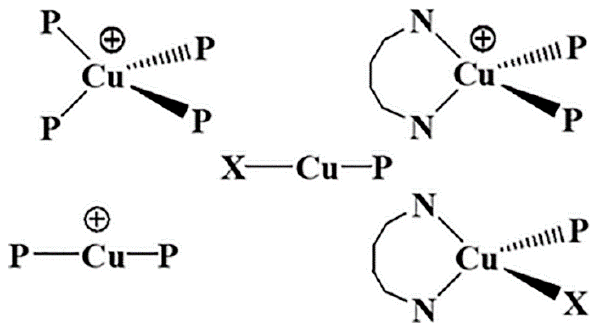
Figure 1. General structures of copper(I) complexes employed in chemotherapy.